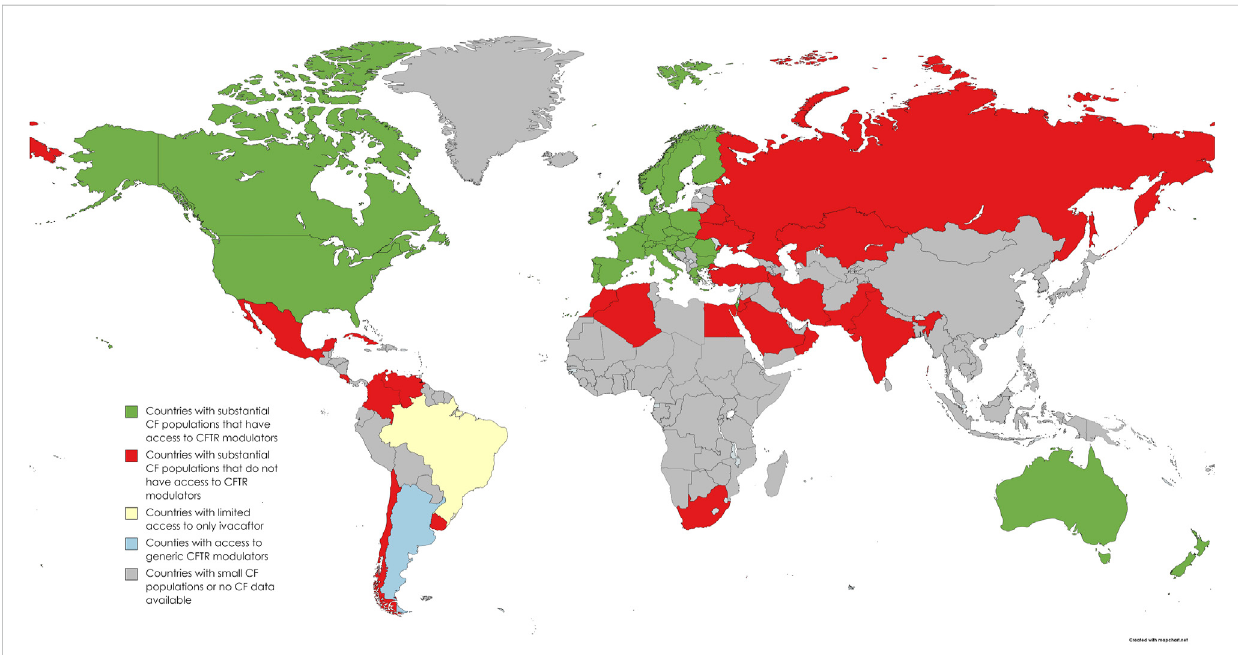
FIGURE 1 World map distribution of countries with access to CFTR modulator drugs or negotiated agreements in place (adapted from Guo et al. (2022a) and personal communications with “ Vertex Save Us ”